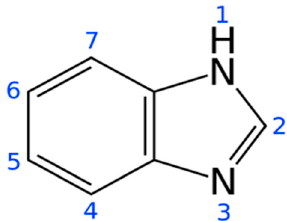
Figure 1. Structure of benzimidazole.